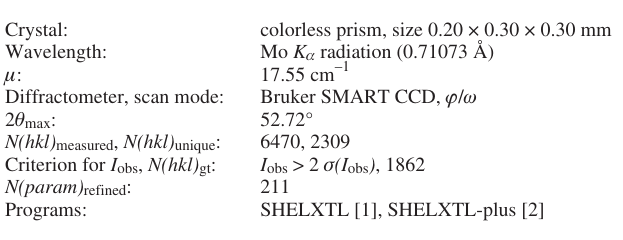
Table 1. Data collection and